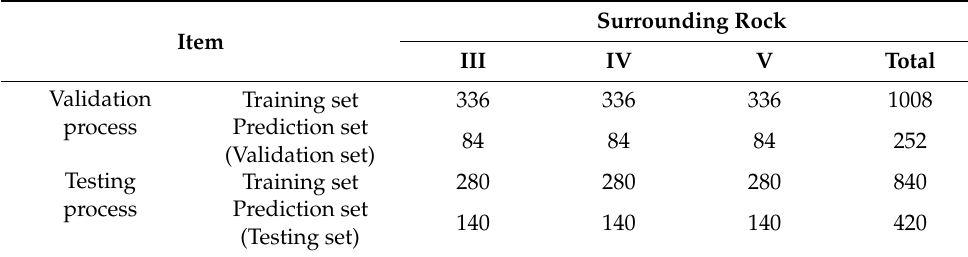
Table 6. Intelligent surrounding rock classification sample database